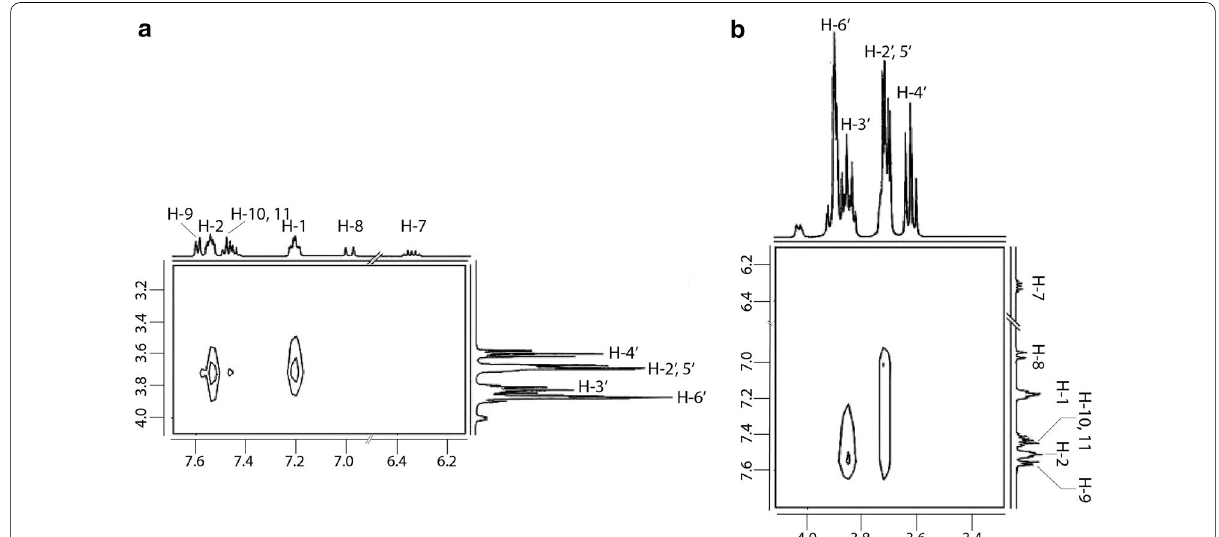
Fig. 2 a and b Partial 2D 1 H- 1 H ROESY (500 MHz) spectra of the mixture of β-CD and FLN showing interactions between FLN and β-CD cavity protons ( τ mix 500 ms) =